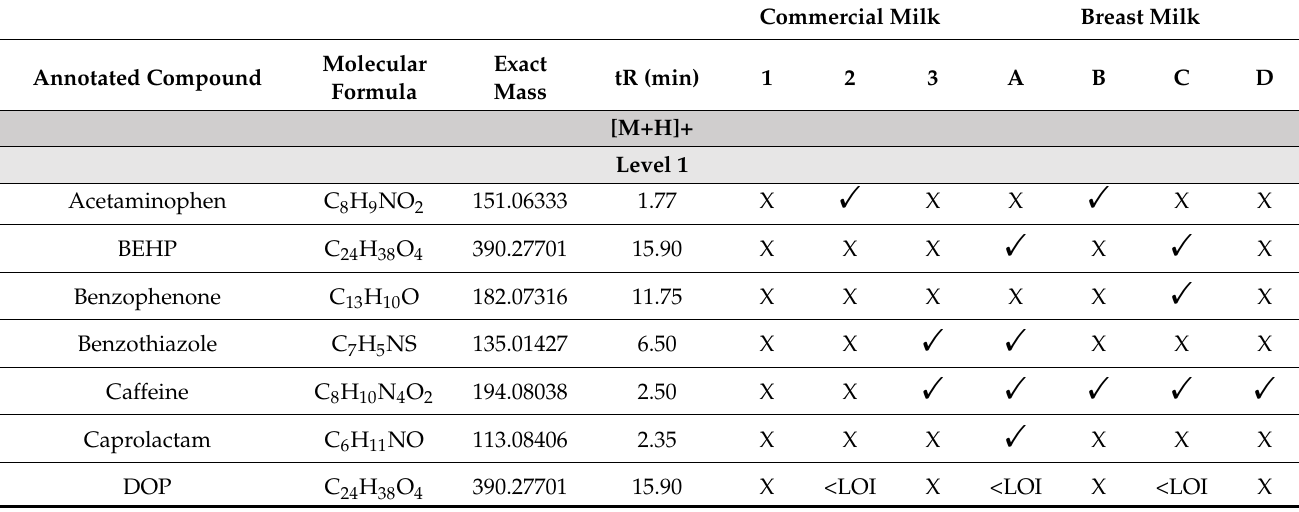
Table 6. Suspect screening of commercial and breast milk: xenobiotics identified at level 1, 2a, 3 and 4.